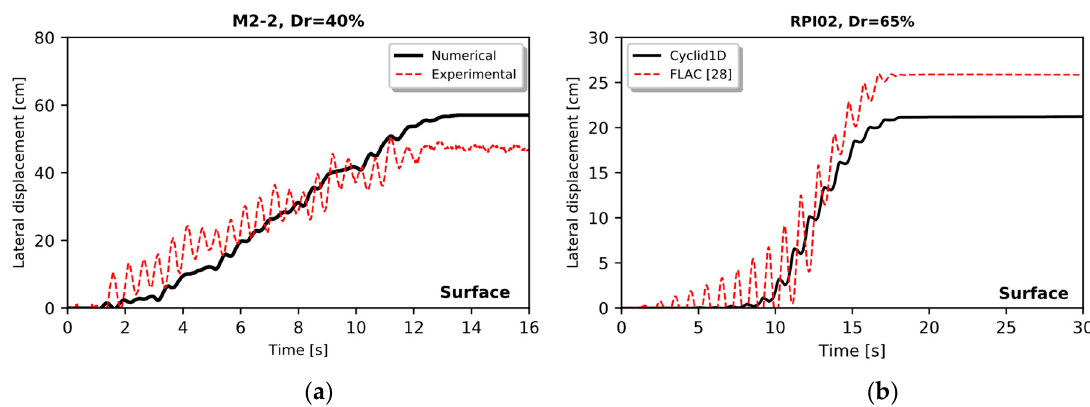
Figure 12. Numerical versus experimental horizontal accelerations in ( a ) M2-2 and ( b ) RPI-02